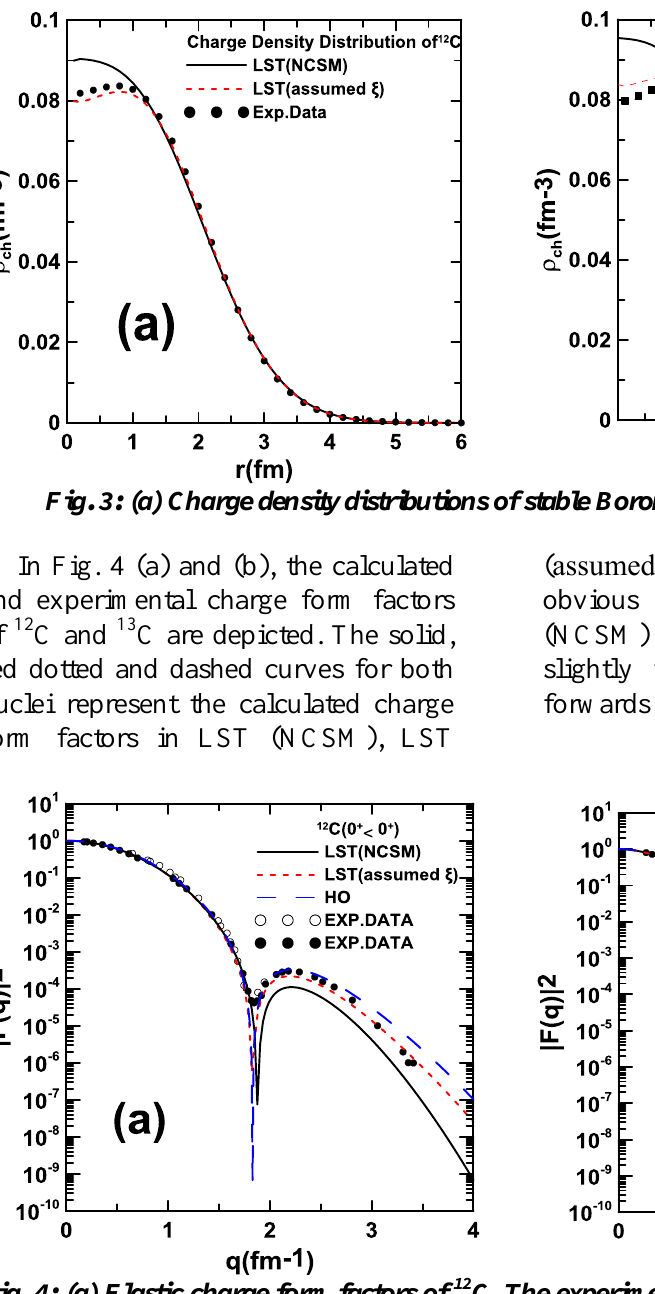
Fig. 4: (a) Elastic charge form factors of 12 C. The experimental data for 12 C represented by empty and filled circles [31]. (b) Elastic charge form factors of 13 C.The experimental data for 13 C represented filled circles